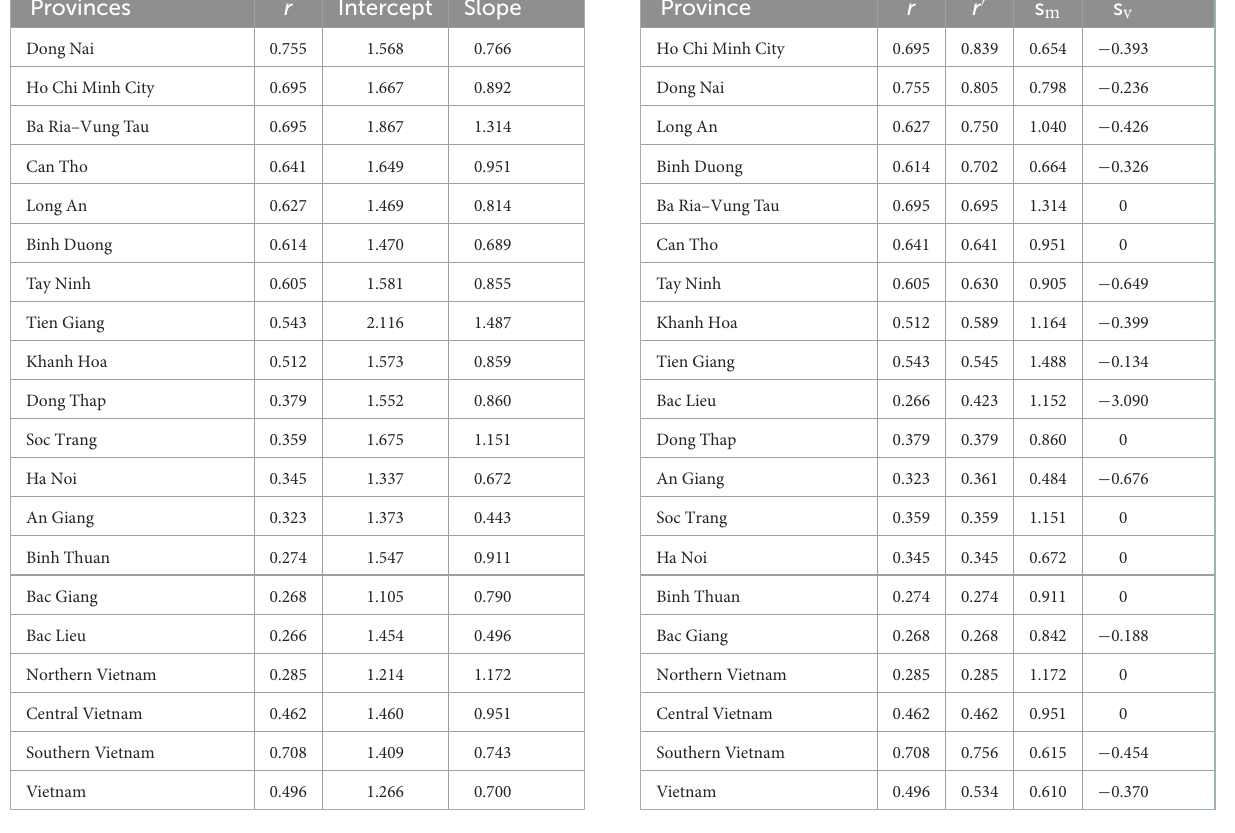
TABLE 4 Results of the linear mobility model with 21 lag-days per month. Provinces r